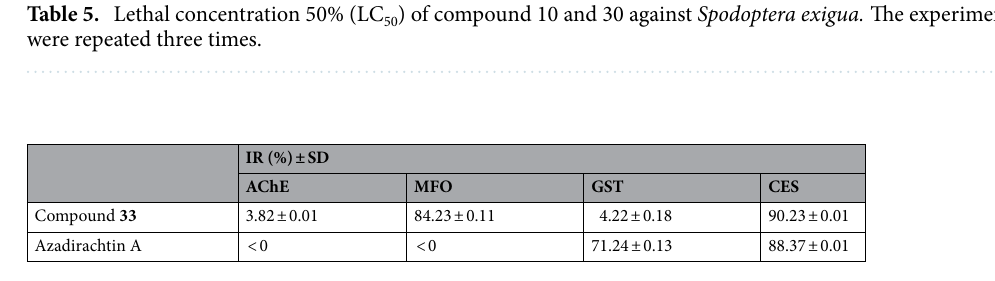
Table 6. Inhibition rate (IR) of enzymes of compound 33 in concentration of 0.5 mg/mL. The experiments were repeated three times. AChE Acetylcholinesterase, MFO Mixed function oxidase, GST Glutathione S-transferases, CES Carboxylesterase.